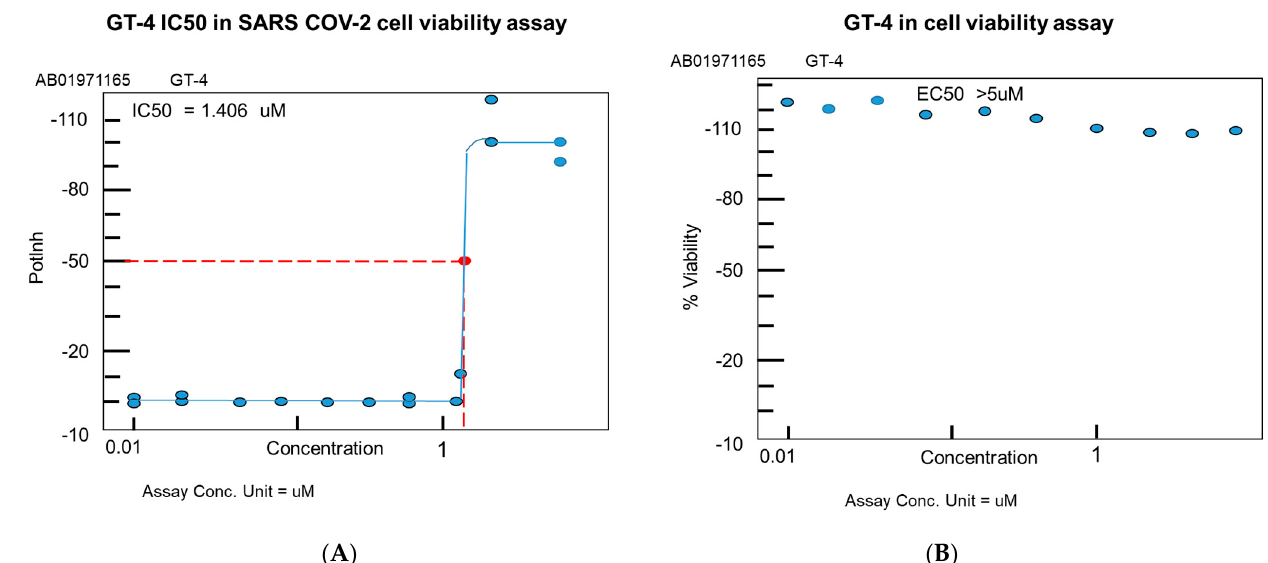
Figure 4. MRCV-19 inhibition of SARS-CoV-2 infection. MRCV-19 inhibition of SARS-CoV-2 infection in a luminescent cell viability assay. ( A ) IC50 values for MRCV-19. ( B ) Measure of MRCV-19 toxicity via a cell viability assay with no virus infection. Testing was conducted in a high-throughput, 384-well plate format with a 10-point dose response curve (common ratio of 2) assayed in duplicate with parallel cytotoxicity evaluation.